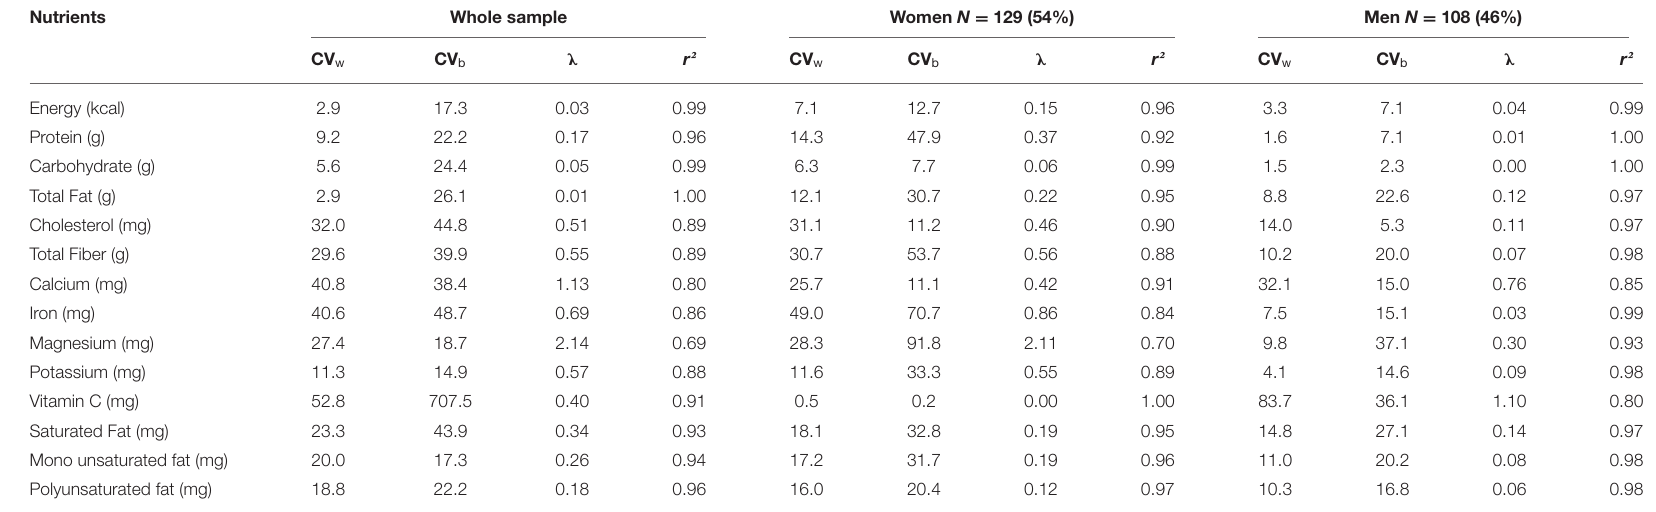
TABLE 2 | Coefficient of variation within person (CV w ) and between person (CV b ), variance ratio ( λ ), and correlation between observed and usual energy and nutrient intake ( r ² ) for the whole sample and by gender. Nutrients Whole sample